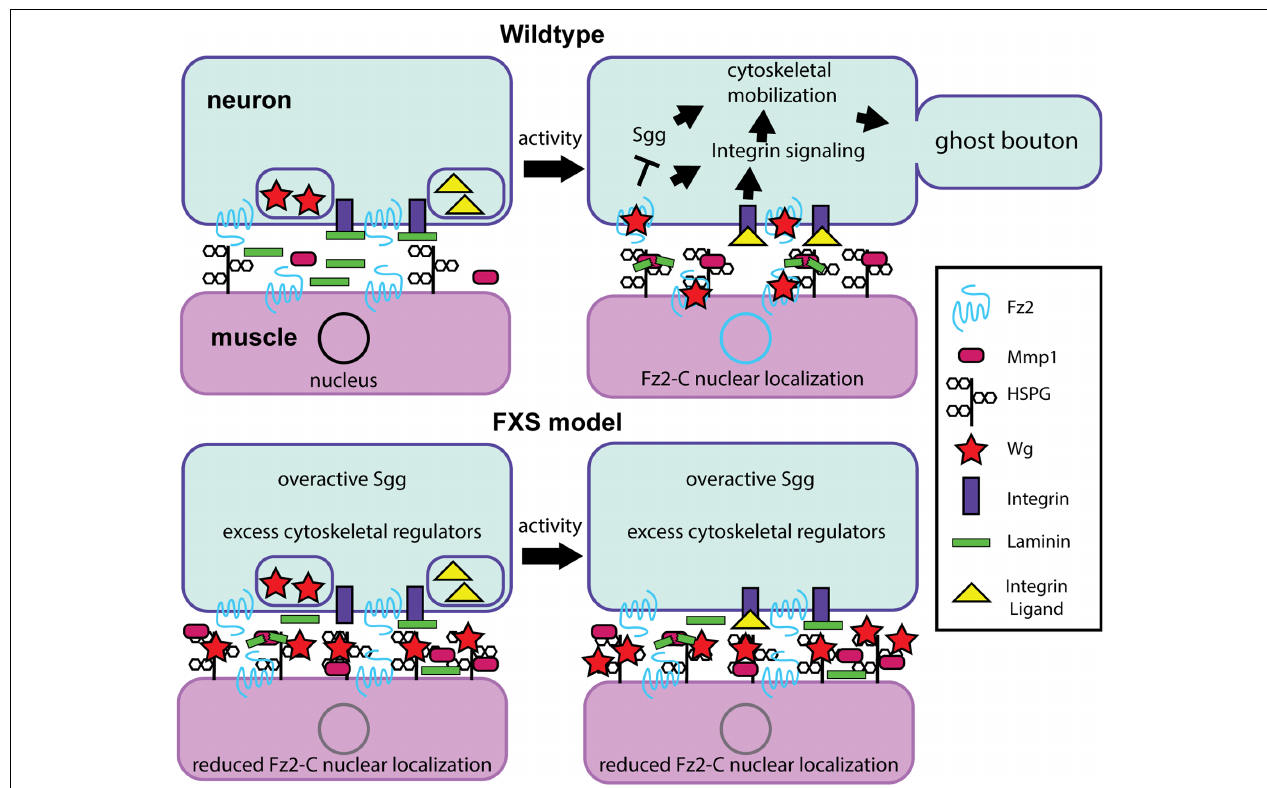
FIGURE 3 | Synaptomatrix trans -synaptic signaling defects in the Drosophila FXS model. Diagram summarizing a new requirement for the secreted matrix metalloproteinase 1 (MMP1) during activity-dependent synaptic remodeling. (Top) In wildtype animals, an activity-dependent FMRP mechanism is required for neural activity to drive heparan sulfate proteoglycan (HSPG) dally-like protein (Dlp) localization at the synapse to recruit MMP1, whose enzymatic function is required for activity-dependent ghost bouton formation. HSPG-MMP1 directed proteolysis drives trans -synaptic Wnt Wingless (Wg) signaling for activity-dependent ghost bouton formation. Activity drives presynaptic signaling via the Frizzled-2 (Fz2) Wg receptor inhibiting GSK3 β /Shaggy and integrin receptor signaling to control cytoskeleton dynamics, and post-synaptic Fz2 C-terminal cleavage and subsequent Fz2-C nuclear localization regulating new protein synthesis. It is hypothesized that MMP1 may cleave synaptomatrix Laminin to regulate ligand interactions with integrin receptors. (Bottom) In the FXS disease model, without FMRP Dlp and MMP1 are significantly increased at the synapse under basal resting conditions, and their levels do not change with activity manipulations. This activity-insensitivity prevents appropriate activity-dependent regulation of trans -synaptic signaling in the synaptomatrix, likely through inappropriate sequestration of the Wg ligand by HSPG Dlp. It is hypothesized that this defect is also linked to improper integrin signaling